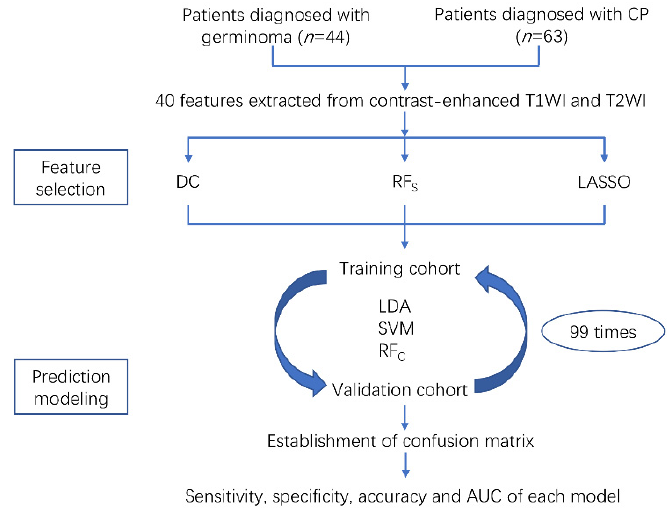
Figure 1. Workflow chart from patient selection to prediction modeling.